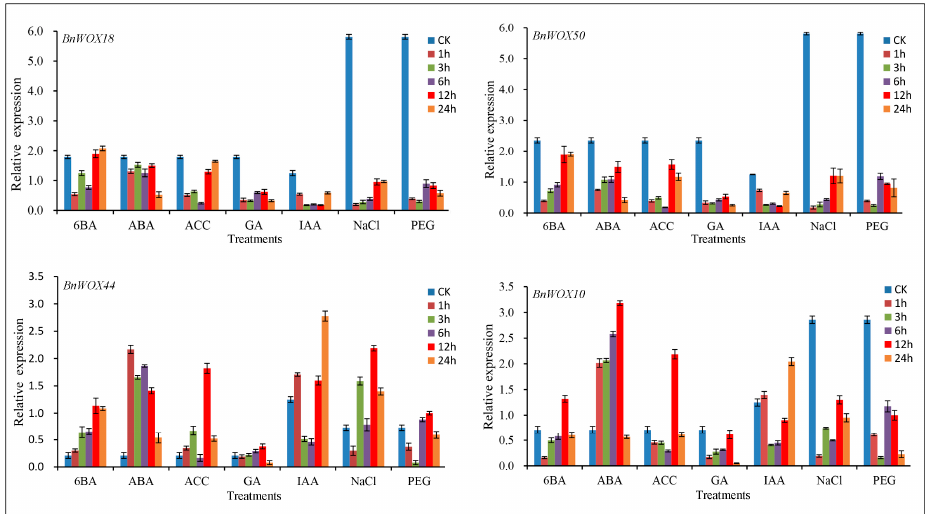
Figure 7. Expression levels of four BnWOX s after different stress treatments. Transcript levels were determined in seedling root samples by qRT-PCR under different stress treatment conditions. PEG simulated the drought stress and NaCl was used for salt stress. Gibberellic acid (GA), abscisic acid (ABA), indole-3-acetic acid (IAA), 1-aminocyclopropane-1-carboxylic acid (ACC) and 6-benzyladenine (6-BA) were used for phytohormone treatments. CK = control. Data are the mean ± standard deviation of three independent